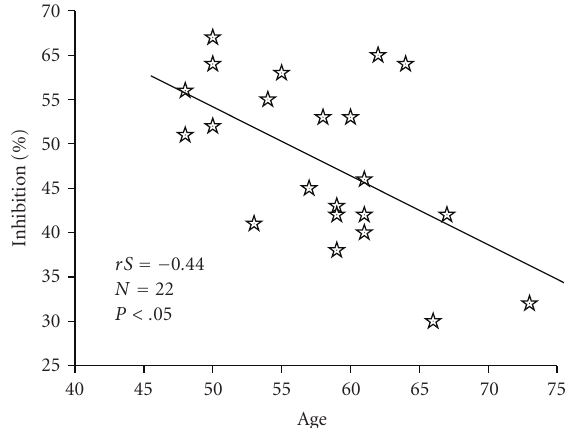
Figure 2: Correlation of the averaged value of the paired-pulse inhibition (evaluated for ISIs of 500, 700, and 900 ms) and age of the healthy age-matched subjects. rS is a coe ffi cient of nonparametric Spearman rank-order correlation. N :-number of control subjects.